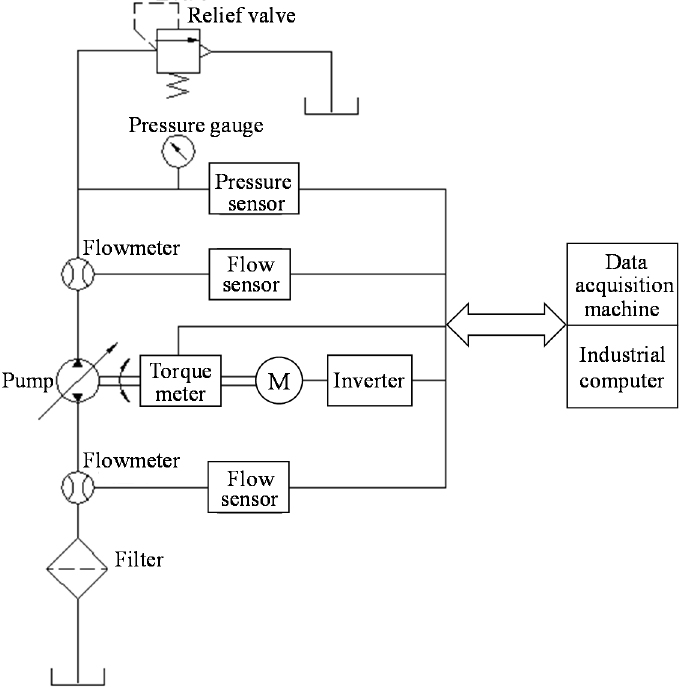
Figure 13. Experimental hydraulic circuit.